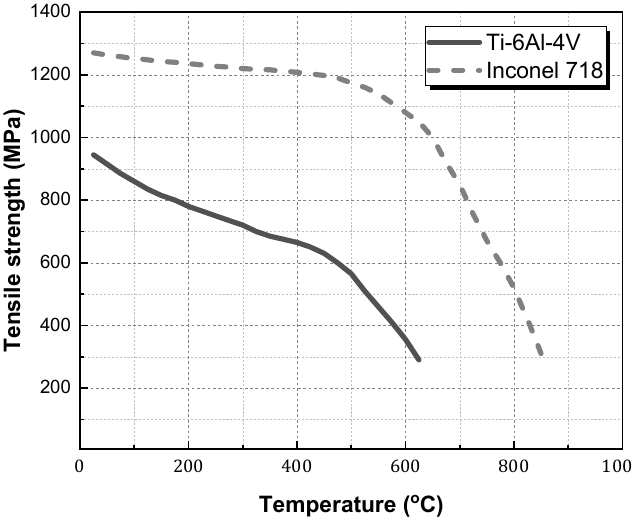
Figure 1. Tensile strength of two materials in dependence on material temperature.